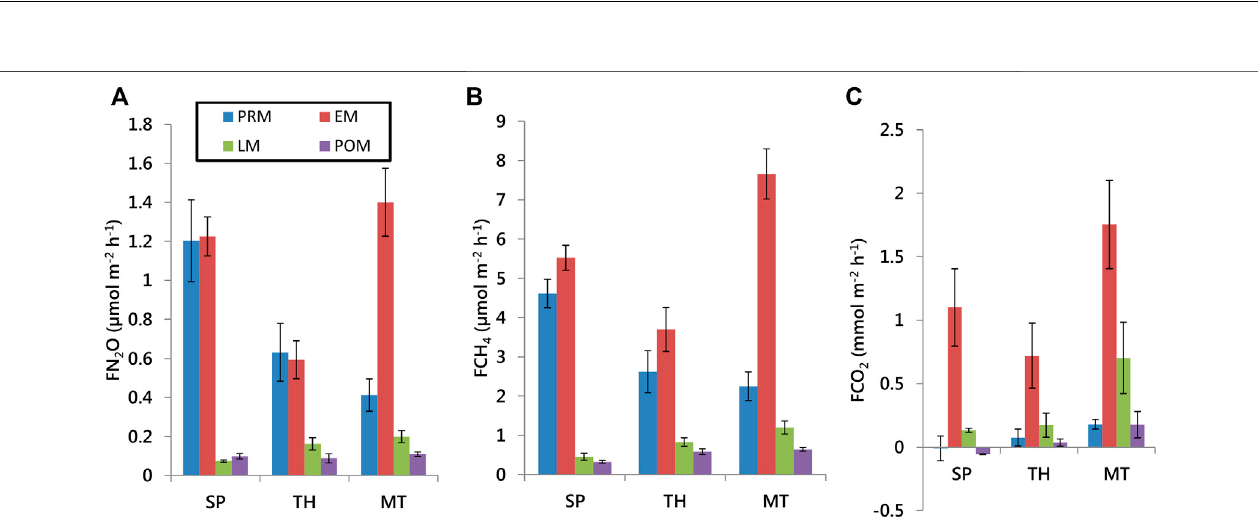
FIGURE 6 | Air/water fl ux densities in the three estuaries of the Indian Sundarbans (SP – Saptamukhi, TH- Thakuran, and MT- Matla in the pre-monsoon, early monsoon, late monsoon, and the post-monsoon).